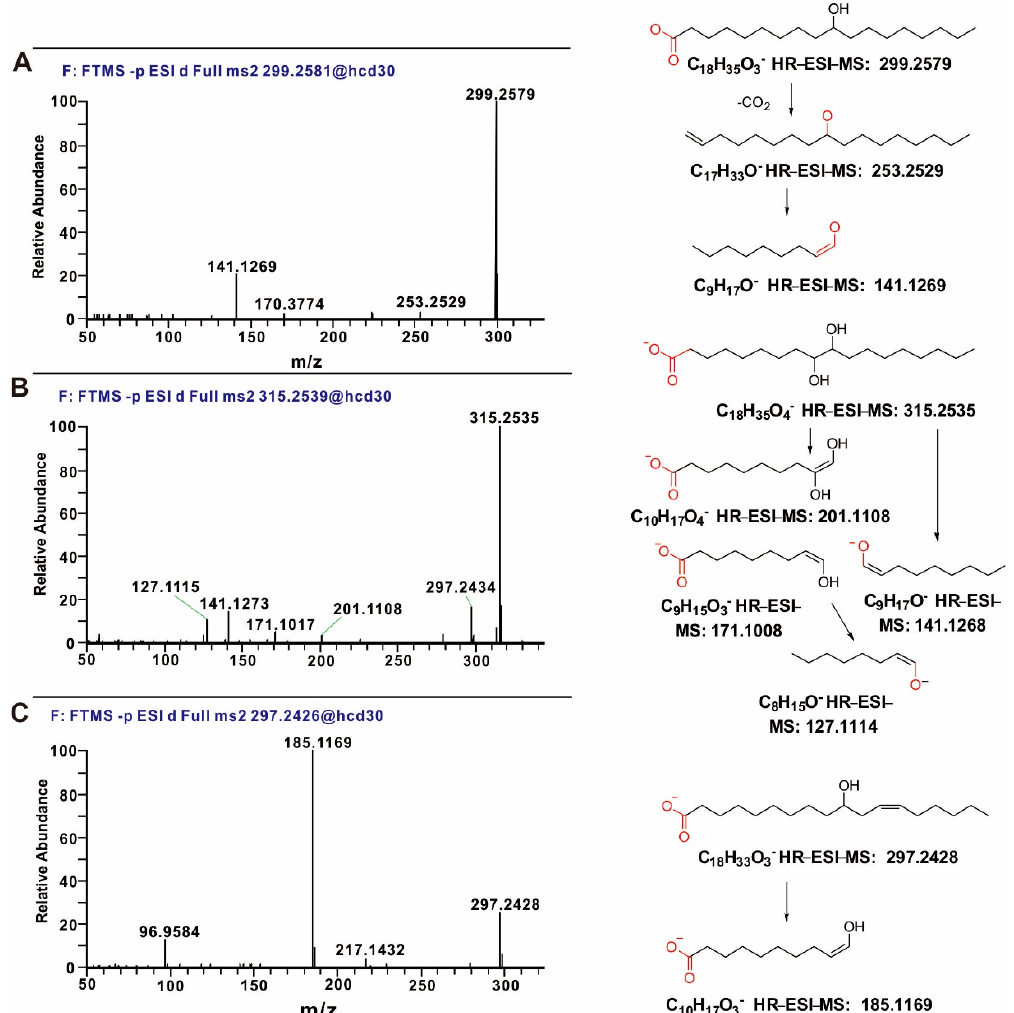
Figure 5. The MS/MS spectra of compounds 1–3. ( A ). The HR-ESI-MS and MS/MS spectra and fragmentation pathway for compound 1 . The HR-MS/MS spectrum of 1 showed the parent ion with m / z 299.2579 and two product ions with m / z 253.2529 and 141.1269. And Proposed fragmentation pathways for compound 1 producing m / z 253.2529 and 141.1269. ( B ). The HR-ESI-MS and MS/MS spectra and fragmentation pathway for compound 2 . The HR-MS/MS spectrum of 2 showed the parent ion with m / z 315.2535 and several key product ions with m / z 201.1108, 141.1273 and 127.1115. And Proposed fragmentation pathways for compound 2 producing m / z 201.1108, 141.1273 and 127.1115. ( C ). The HR-ESI-MS and MS/MS spectra and fragmentation pathway for compound 3 . The HR-MS/MS spectrum of 3 showed the parent ion with m / z 297.2428 and the key product ion with m / z 185.1169. And Proposed fragmentation pathways for compound 3 producing m / z 185.1169. Compound 2 was obtained as a colorless, amorphous solid. Negative HR-ESI-MS data indicated a molecular formula of C 18 H 35 O 4 based on the [M − H] − ion with m / z 315.2536 (calc. 315.2530). According to MS and NMR data, 2 was identified as doubly hydroxylated octadecanoic acid. The exact positions of the hydroxyl groups were elucidated using MS/MS. The MS/MS spectrum of 2 (Figure 5B) featured the peak of the parent ion as well as those of five product ions with m / z 297.2434, 201.1108, 171.1017, 141.1273, and 127.1115. Among them, the ion of m / z 297.2334 was produced through the loss of one hydroxyl group not involving C–C bond cleavage, whereas the other four ions could be formed through C–C bond cleavage and provide clues for determining the hydroxyl group positions. According to the literature, the fragmentation of fatty acids with